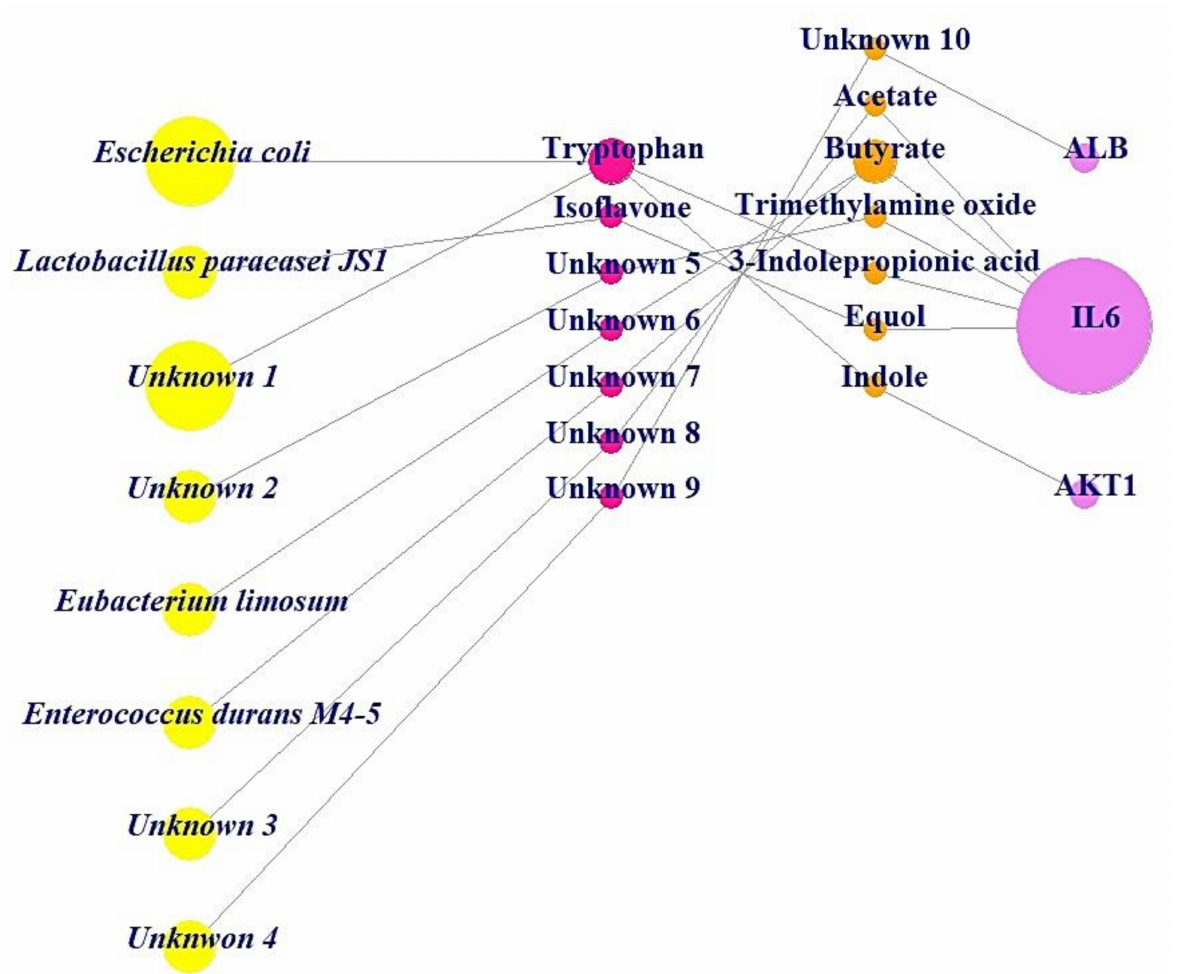
Figure 4. MSMT networks (25 nodes, 23 edges). Yellow circles: microbiota (probiotics); red circles: substrate (prebiotics); orange circles: metabolites (postbiotics); pink circle: target.